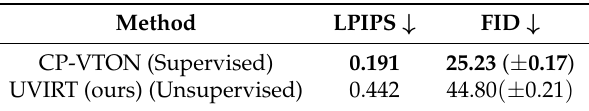
Figure 3. Qualitative comparison of proposed UVIRT vs. CP-VTON on the test images of the MPV dataset. The left figure shows the results of reconstructing the reference images using the target clothing. The right figure shows the results of warping target clothing to reference images. Although our UVIRT method changes the person’s poses, ours can warp clothing to the persons in each of the experiments. Thus, our UVIRT method achieves competitive performance in the virtual try-on task. Table 1. Quantitative comparison of proposed UVIRT vs. CP-VTON on the test images of the MPV dataset. Lower is better in the LPIPS and FID metrics, means and standard deviations are shown. The bold characters indicate the highest